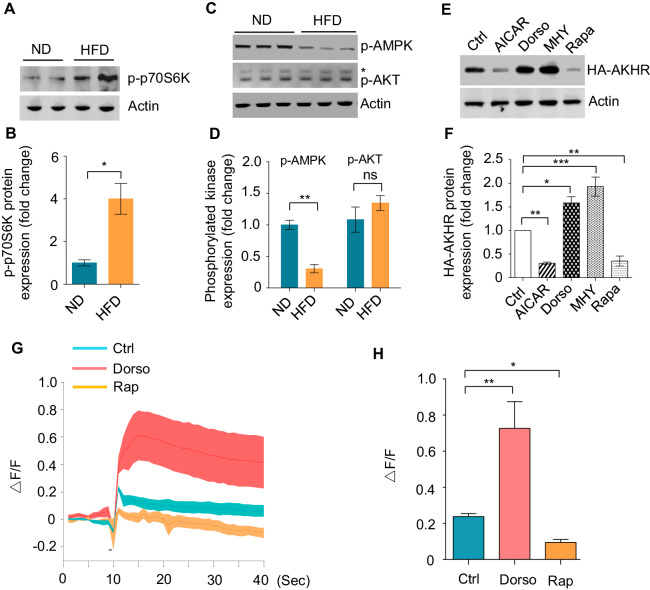
HFD activates TOR signaling.(A–D) p70s6k/AKT/AMPK phosphorylation under ND vs. HFD feeding conditions. The head tissues of wild-type flies fed with ND or HFD were harvested and subjected to western blot with phosphorylated p70s6k antibody (A–B) and p-AKT/p-AMPK antibodies (C–D) (n = 3 biological replicates, each containing 25 flies). *Nonspecific bands. (E–F) AKHR accumulation upon pharmacological manipulation of AMPK-TOR signaling in cultured Drosophila S2 cells (n = 3). Cultured S2 cells transiently expressing AKHR-HA were treated with the indicated chemicals and then analyzed by western blot with HA antibody. (G–H) Representative traces (G) and quantification (H) of peak calcium responses of AKHR+ neurons to 316 nM AKH, with or without the indicated drug treatment (n = 7–10). ns, p>0.05; *p<0.05; **p<0.01; ***p<0.001. Student’s t-test and one-way ANOVA followed by post hoc test with Bonferroni correction were used for pair-wise and multiple comparisons, respectively.Figure 5—source data 1.Top differentially expressed genes upon HFD feeding.Wild-type virgin female flies were fed with ND or HFD for 5 d before their head tissues harvested and subjected to RNAseq. Top 40 differentially expressed genes (20 up-regulated and 20 down-regulated) were shown.